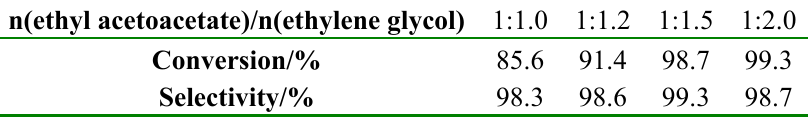
Table 1. The effect of the molar ratio on the reaction.